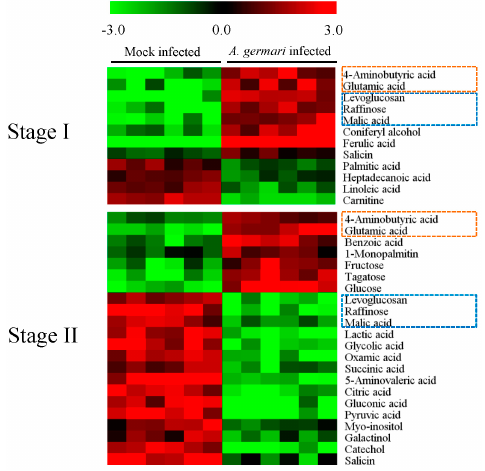
Figure 4. A. germari induced differential metabolites in xylem tissues. Black bars denoted the sample classes. The columns and rows represented the individual tissue samples and distinct metabolites, respectively. The elevated and decreased levels of a metabolite were showed by increases in the intensities of red and green, respectively. Metabolites which appeared in both stages were marked with boxes. The orange and blue boxes marked metabolites showed similar and opposite changes between stage I and II,